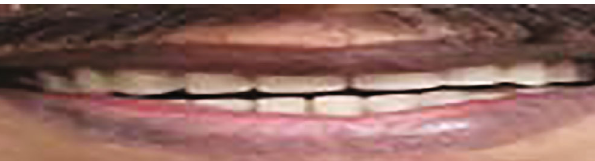
Figure 3: Oral examination after Immediate denture replacement (after 3 months). Table 2: Models of breaking bad news. Model